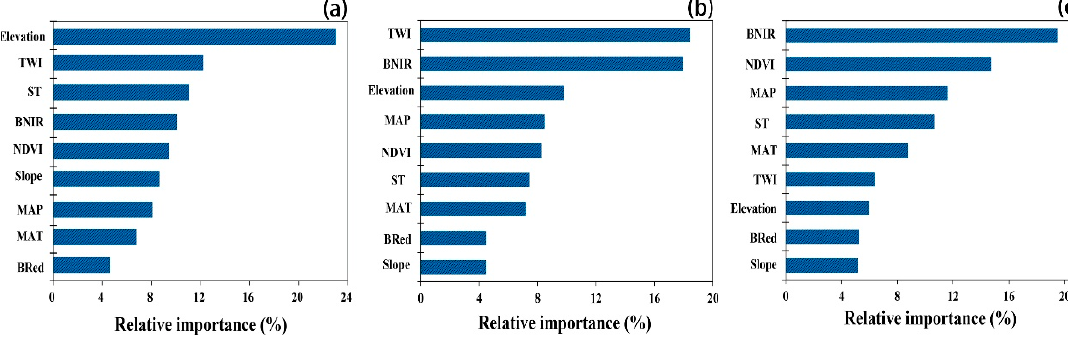
Figure 4. Relative importance of each predictor as determined from 100 runs of the RF model: ( a ) 1979, ( b ) 2004, and ( c ) 2014.